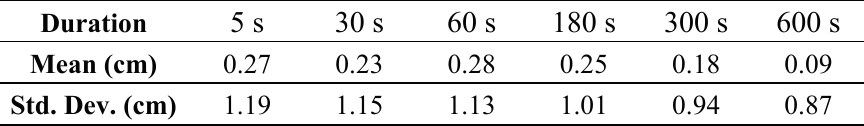
Table 3. Statistics of the multiple-epoch solutions by